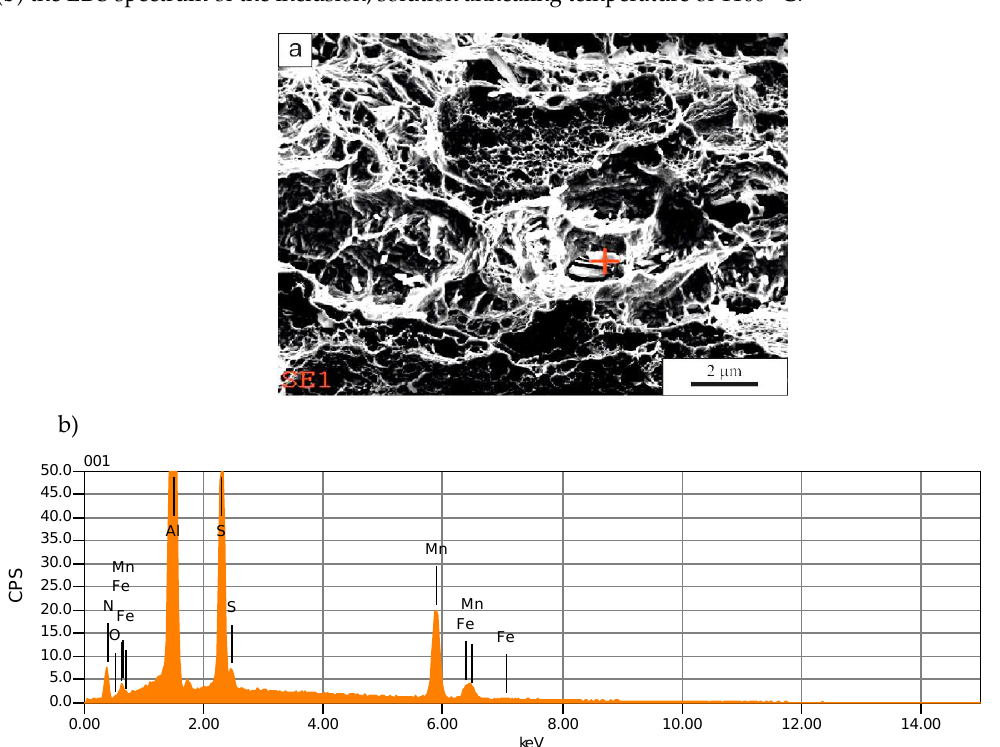
Figure 7. Complex non-metallic inclusion consisting of MnS and AlN: ( a ) the inclusion view, ( b ) the EDS spectrum of the inclusion; solution annealing temperature of 1200 °C.